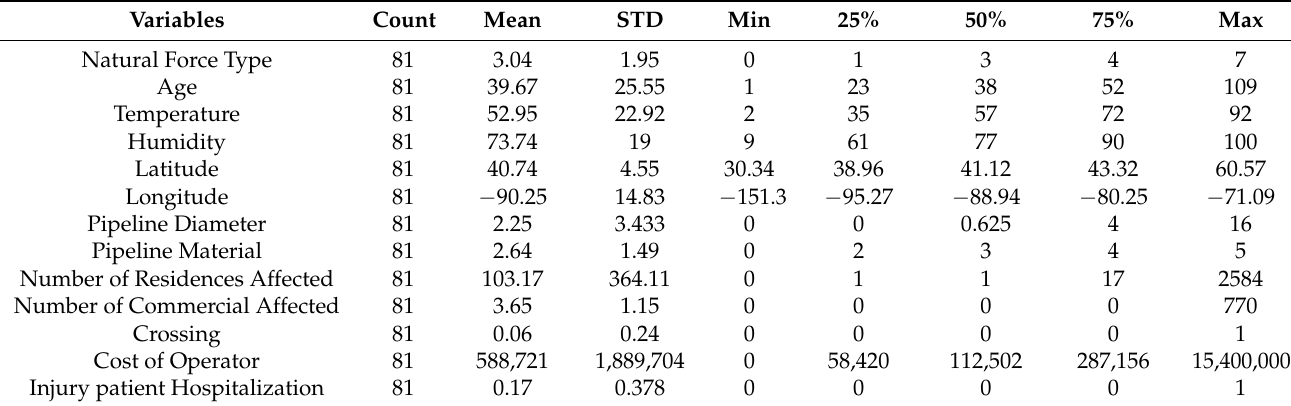
Table 3. Statistical summary of response and predictive